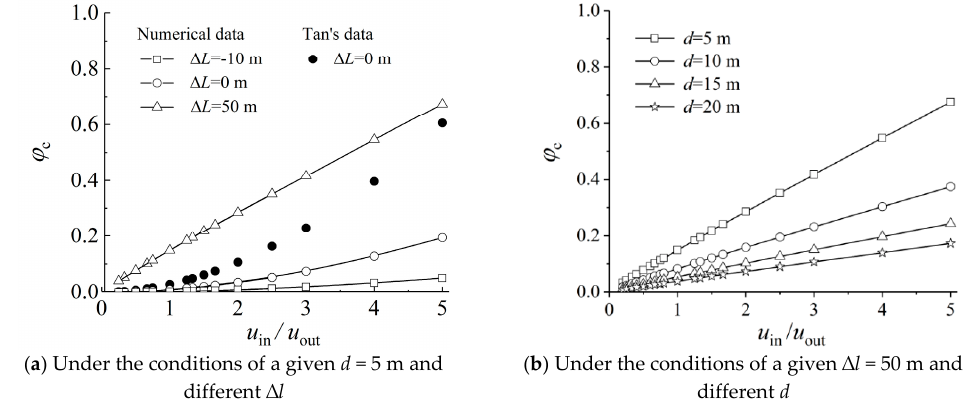
Figure 11. Impacts of velocity ratio u in / u out on circulating air mixing ratio φ c.